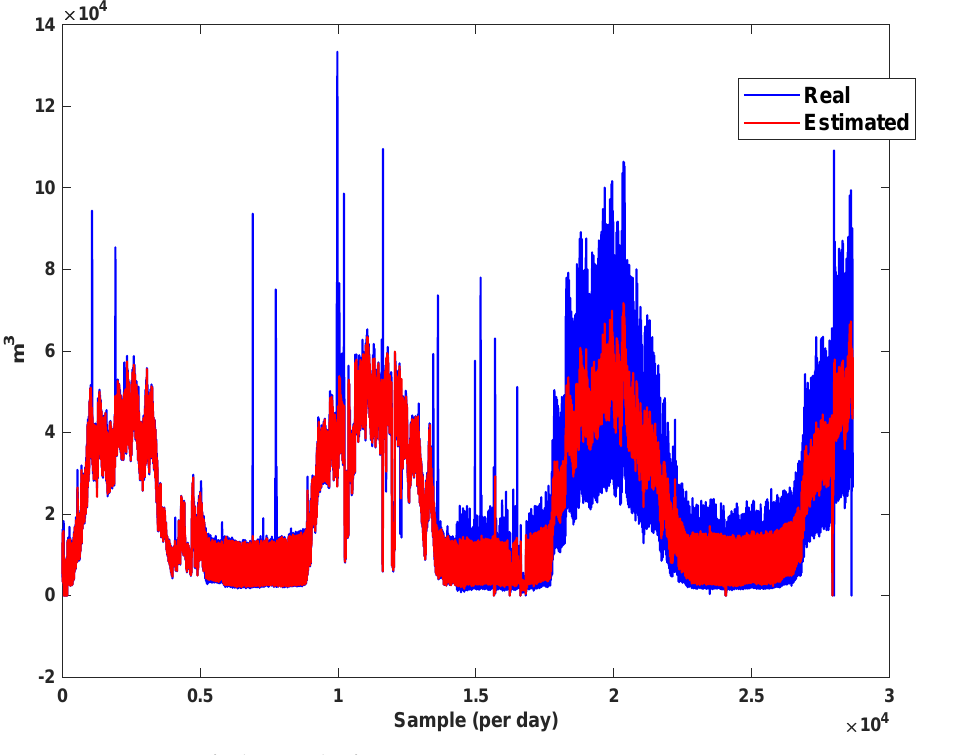
Figure 26. Detection fault 4: Peak of consumption. Table 1. Comparison results.